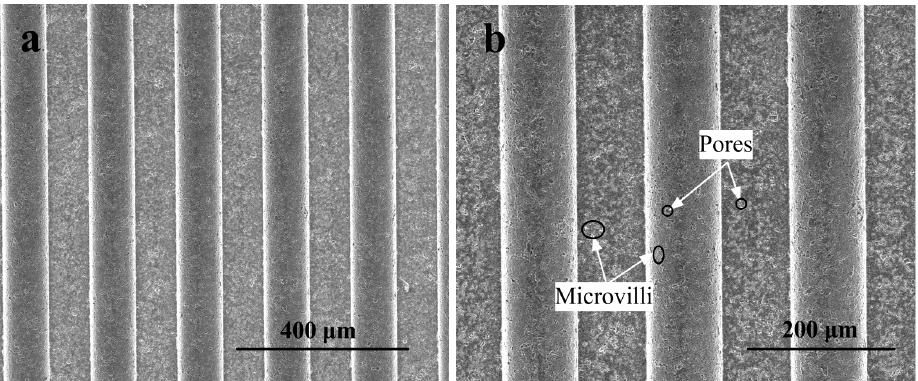
Figure 5. SEM photos of the micro-structured mold core surface: ( a ) surface topography of machined mold core; ( b ) the magnified version of Figure 5a.